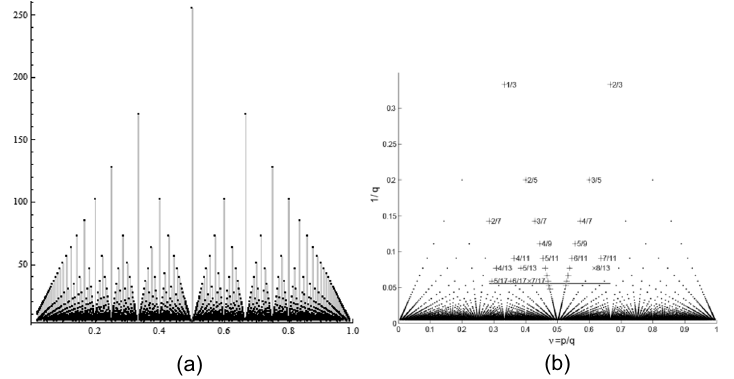
Figure 4 . (a) Regularization of the normalized everywhere discontinuous Riemann function f 1 ( x ) = (cid:0) π (cid:1) 1 / 2 g ( x ) (points) by the everywhere continuous function f 2 ( x ) = 12 ε y = 10 − 6 in the interval 0 < x < 1 ; (b) The stability diagram of Tao-Thouless Fractional Quantum Hall states reproduced from